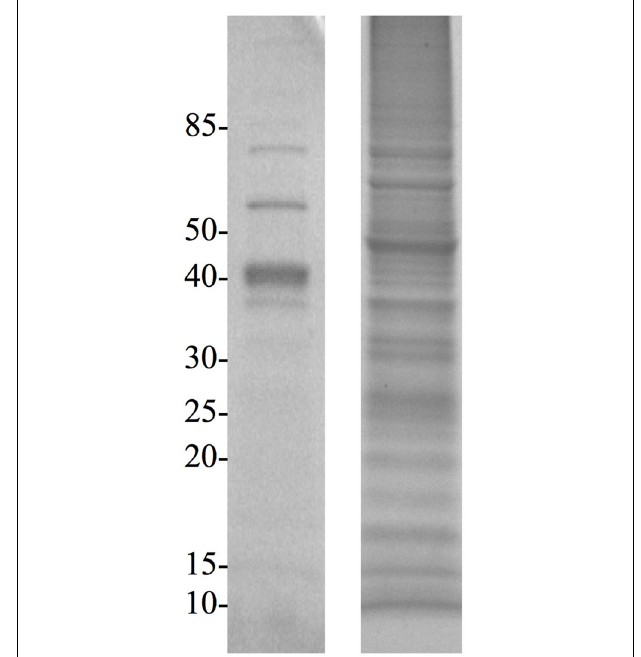
FIGURE 5 | SDS-PAGE gels of osmotic-shock fraction (left) and crude extract (right) stained with Coomassie Blue. Molecular masses (in kDa) are indicated on the